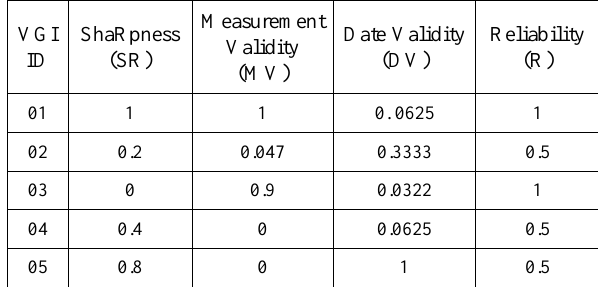
Table 4: computation of quality indicators for the simulated VGI items depicted in Table